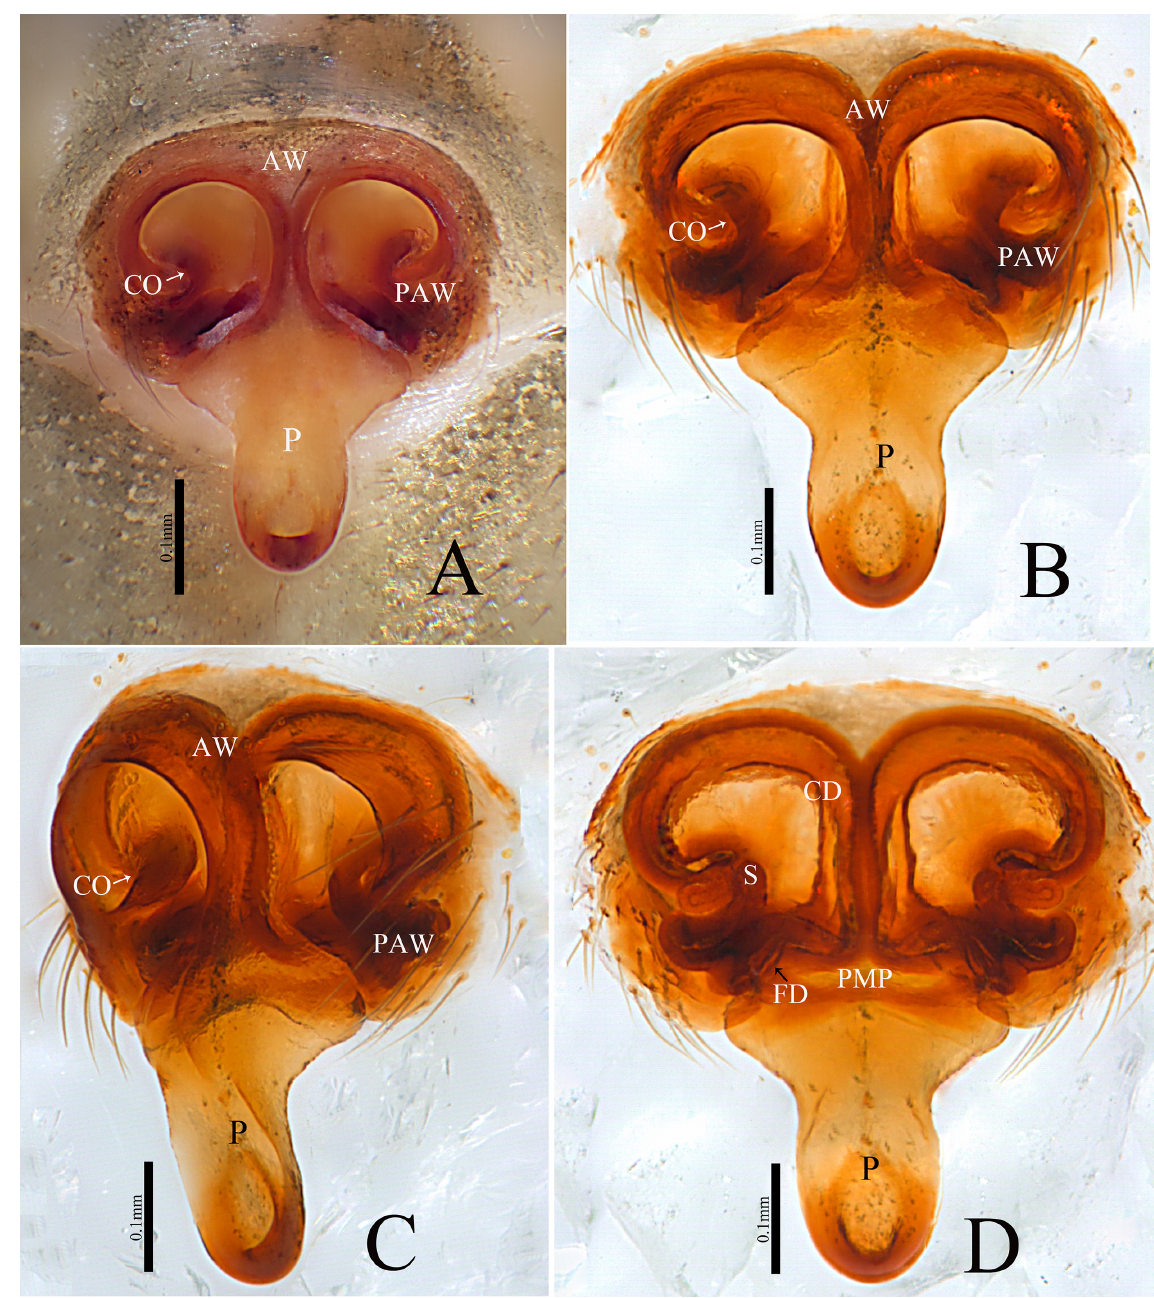
Fig. 22. Acroterius inversus gen. et sp. nov., ♀, holotype (HNU-CGY115). A–B . Epigyne, ventral view. C . Epigyne, lateral view. D . Vulva,